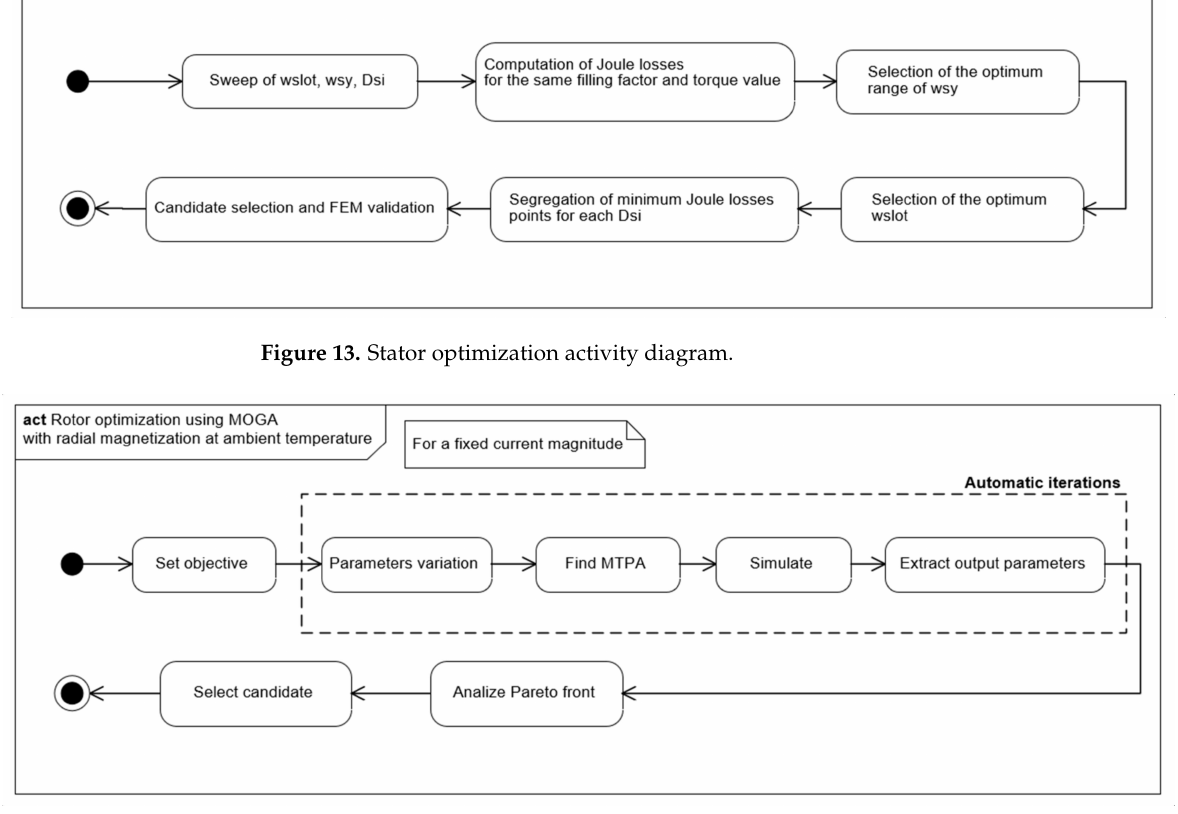
Figure 14. Rotor optimization activity